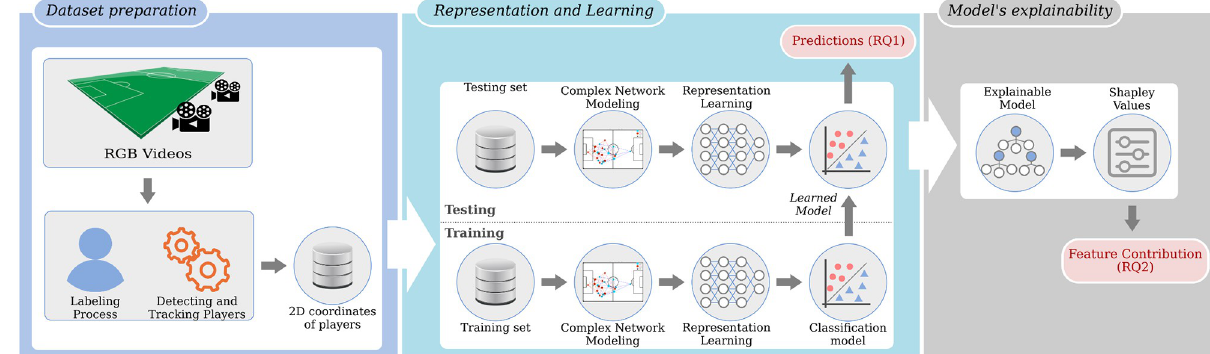
Fig 1. Proposed method. Given a set of soccer videos, the proposed method consists of detecting and tracking the players in the field toward obtaining their (x,y)-coordinates. Then, we divided the tracking data into training and testing subsets, using the k-fold cross-validation protocol. Next, we model the interaction between players using complex networks, in which the nodes represent players, while edges the chances of passing the ball to teammates. Thus, we extract representations for the built complex network and use the visual rhythms technique to summarize such features for a time window. Finally, we use the visual rhythms maps to build a classifier for predicting the changes of an attack move reaching the attack zone, and also an explainable method to estimate the contribution of input features.